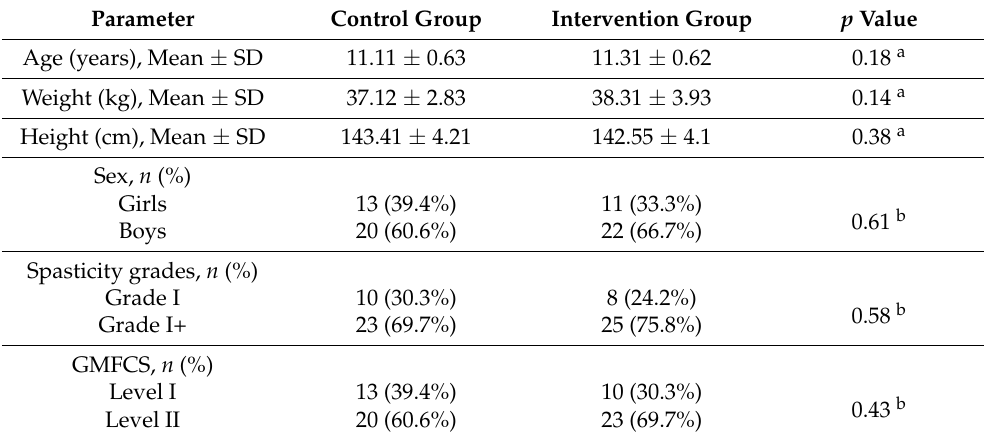
Table 2. Participant